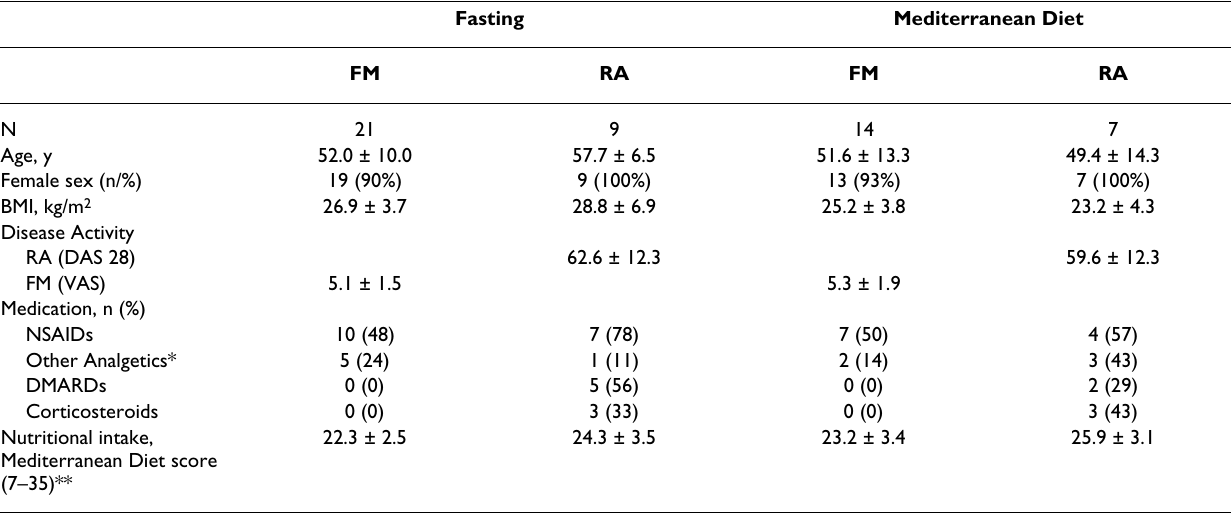
Table 1: Baseline characteristics according to diagnosis and nutritional